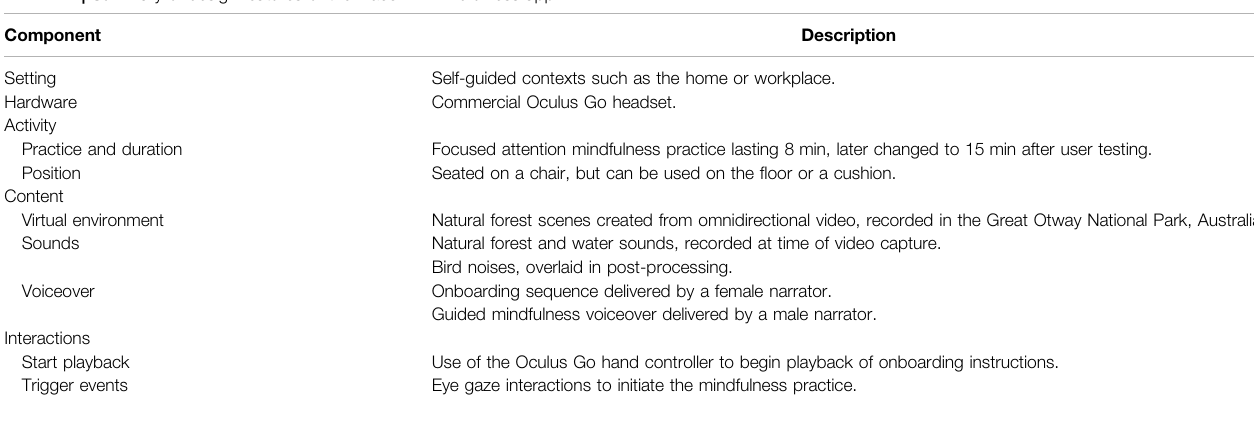
TABLE 1 | Summary of design features of the Place VR mindfulness